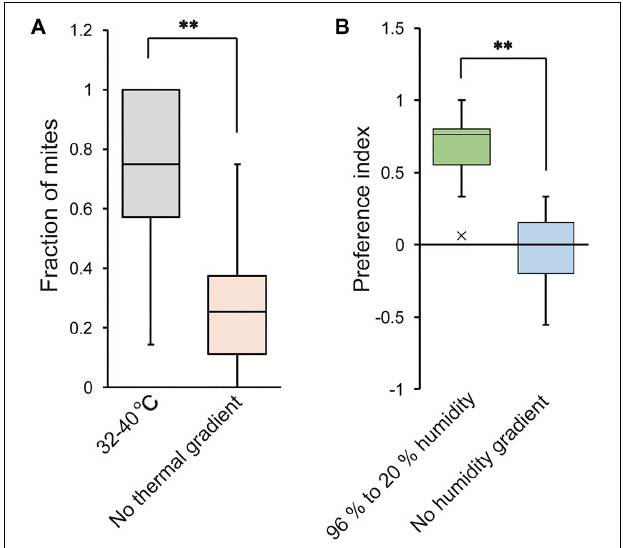
FIGURE 5 | Temperature and humidity preferences of T. mercedesae. (A) The fraction of mites in the area of 32–40 ◦ C ( n = 18) and the same area but without thermal gradient ( n = 21) is shown. Asterisk ( ∗∗ ) indicates the significant difference between two groups ( P -value < 0.001, two-tailed Welch’s t -test). (B) Preference index of mites in the testing arena with 96% to 20% humidity ( n = 20) and without humidity gradient ( n = 12) is shown. Asterisk ( ∗∗ ) indicates the significant difference between two groups ( P -value < 0.001, two-tailed Welch’s t